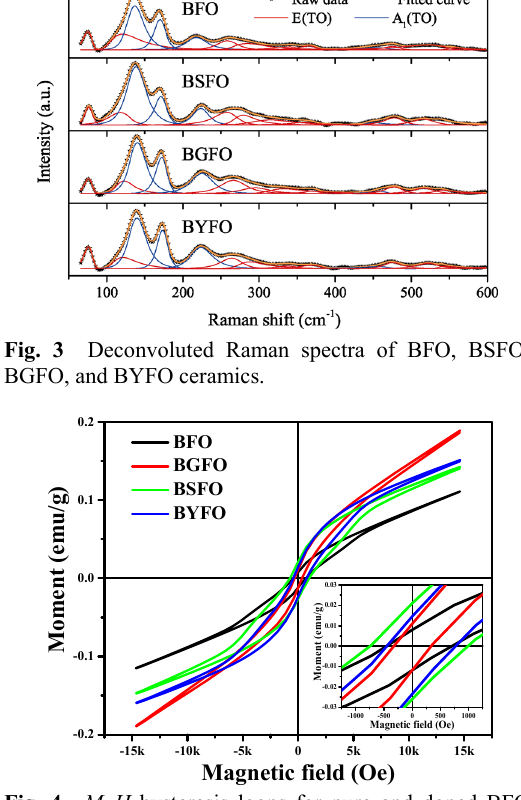
Fig. 4 M – H hysteresis loops for pure and doped BFO ceramics, and the inset depicts partial enlarged curves. Table 2 Comparison of the Raman mode positions of different component samples